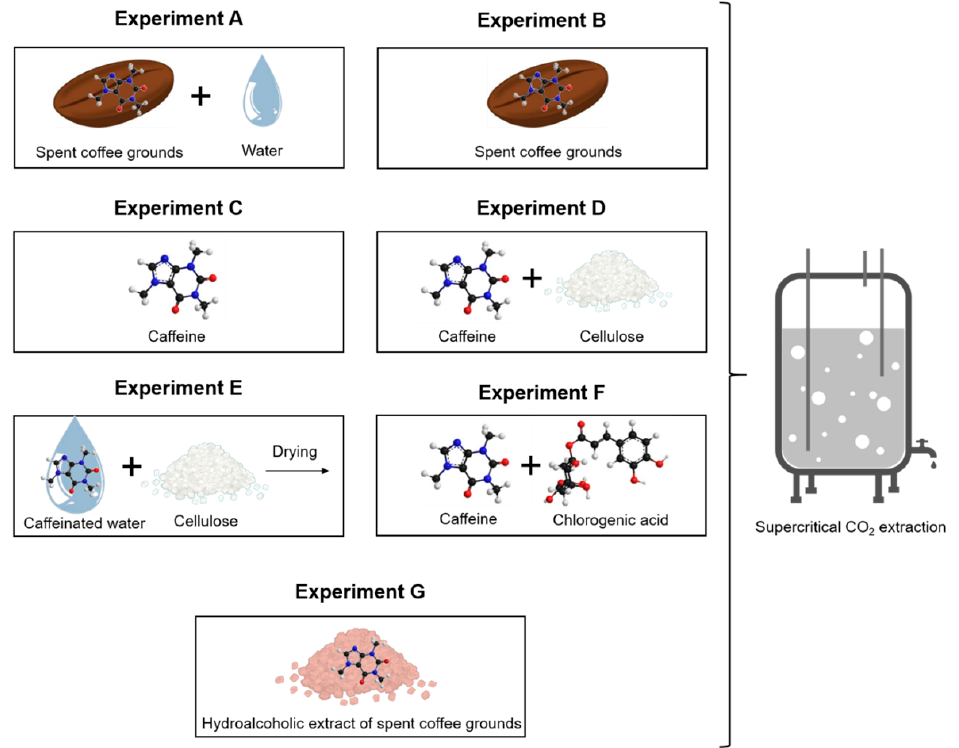
Figure 3. Explanatory diagram of additional manipulations performed with supercritical CO 2 at 265 bars and 55 °C to understand the mechanism of extraction with supercritical CO 2 in the presence of water.